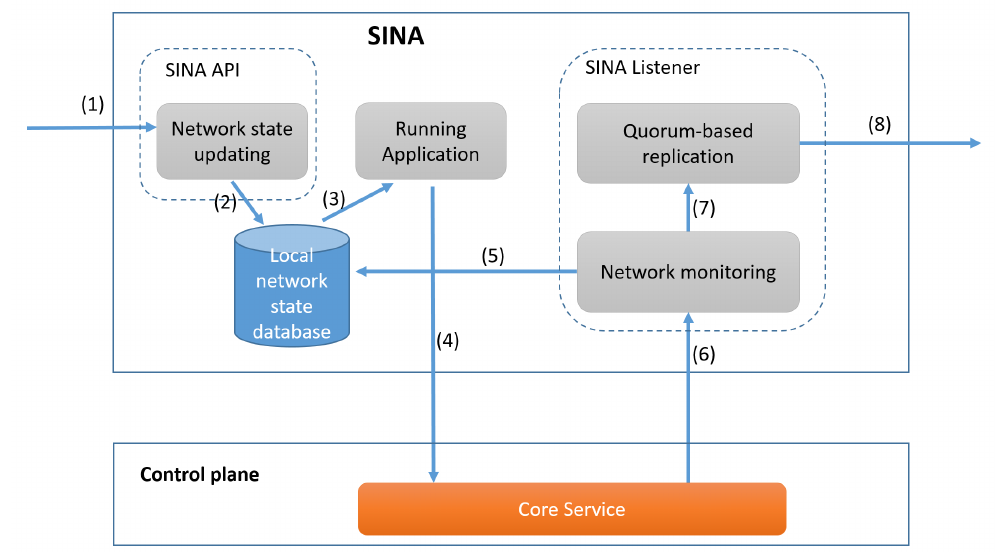
Figure 5. SINA architecture with the adaptive, quorum-based replication module. The numbers (1)–(8) represent flow